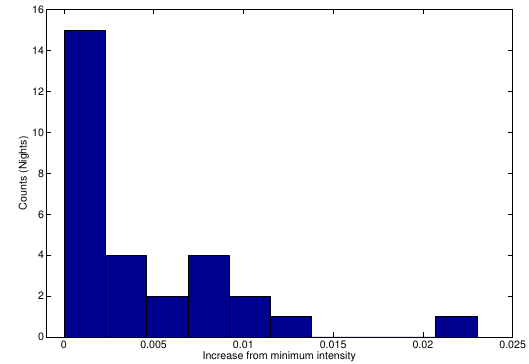
Figure 3: Histogram of nightly optical intensity vari- ations. In order to examine the sinusoidal modulation, light curves were shifted by the amounts shown in the histogram. Zero on this linear scale is the relative in- tensity of the minimum observed nightly mean. For example, the first night shown in Figure 1 is shifted down by approximately 0.013 to remove the night to night variation. On most nights V1408 Aql remained near minimum intensity, while on one night (14 July 2012) it showed a particularly high